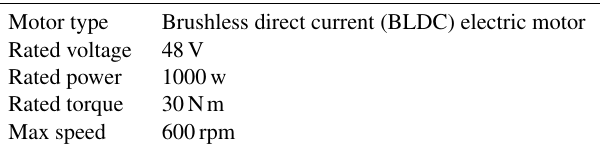
Table 1. Specifications of hub motor. Table 2. Specifications of the lithium battery pack.